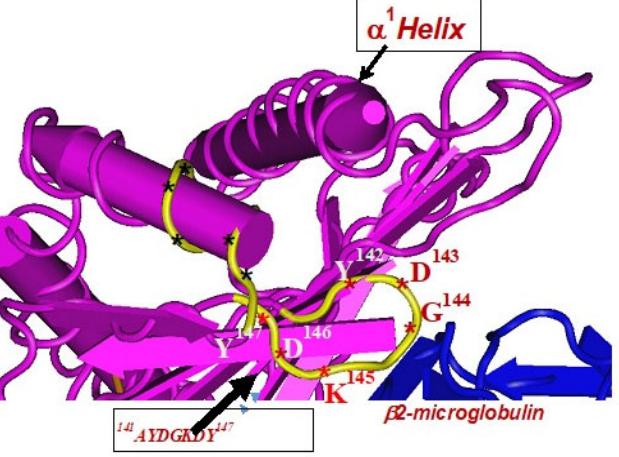
Figure 5. The amino acid sequences of α 2-domain of HLA-I shared by HLA-A, B, C, E, F and G loci, that are hidden (cryptic domain) by β 2-microglobulin. These sequences are highly immunogenic. For details see Table 3.